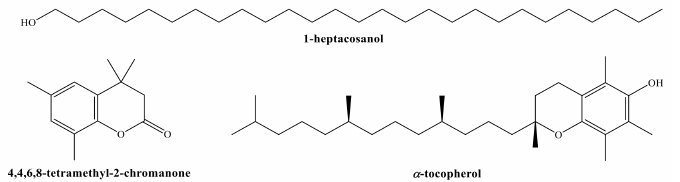
Figure 1. Structures of main phytochemicals found in H. syriacus cv. Mathilde : 1-heptacosanol;